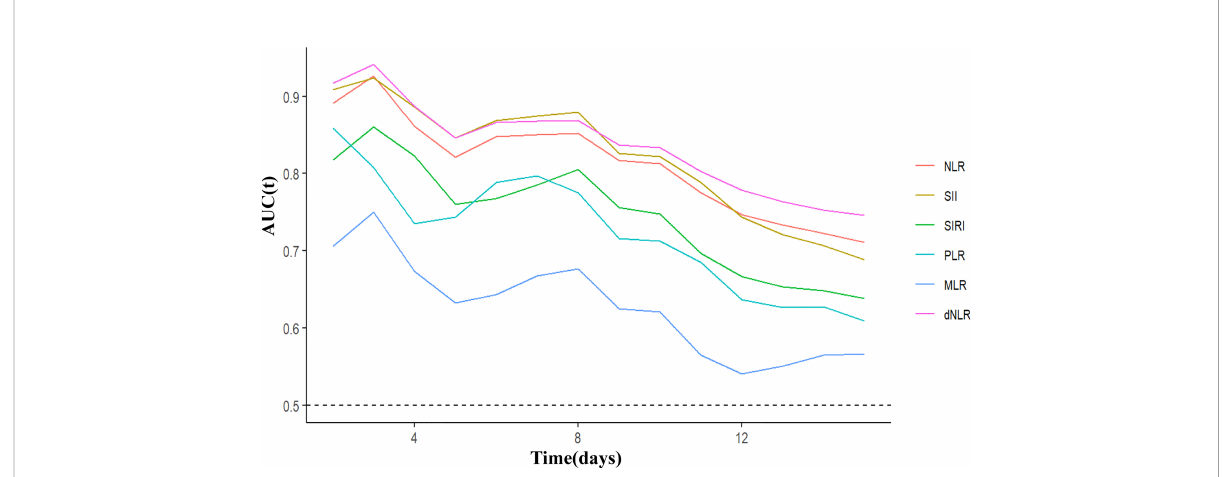
FIGURE 3 Time-dependent ROC of in fl ammatory indicators for diagnosing overall survival in COVID-19 Omicron BA.2 infected patients. dNLR, derived neutrophil to lymphocyte ratio; NLR, neutrophil to lymphocyte ratio; SII, systemic immune-in fl ammation index; SIRI, systemic in fl ammation response index; PLR, platelet to lymphocyte ratio; MLR, monocyte to lymphocyte ratio.